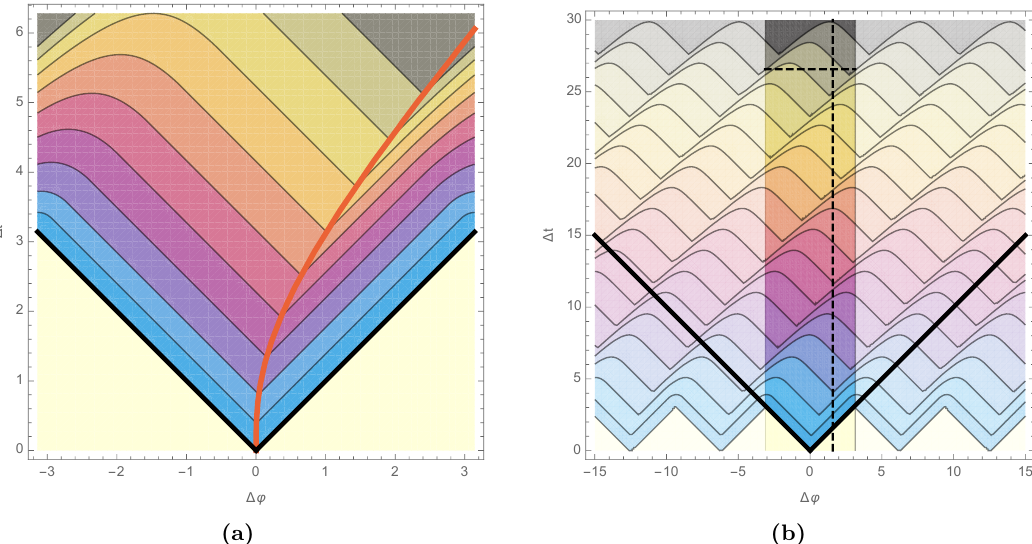
Figure 6. Contour plots of the eikonal phase δ (∆ ϕ, ∆ t ) in extremal BTZ, for r + = 1 , and where the n th contour level is given by a cubic function ( cn + d ) 3 with c = 10 − 7 and d = 10 − 7 in (a) and ( cn + d ) 3 with c = 10 − 7 and d = 15 · 10 − 7 in (b). A cubic function would therefore have equidistant contour lines. (a) At small times, a single image contributes to the eikonal phase. The orange line characterizes the spatial separation for which δ is maximal at a fixed time separation, which corresponds to the boundary insertions for which the two geodesics cross with zero impact parameter in the bulk. On the right of this line, the growth as a function of time is exponential, while on the left there is power law growth. (b) The contour plot is extended for larger time separations, involving multiple images, while highlighting the physical domain ∆ ϕ ∈ ] − π, π ] . The behaviour of the eikonal phase along the vertical and horizontal dashed lines are shown in figures 3 and 7,